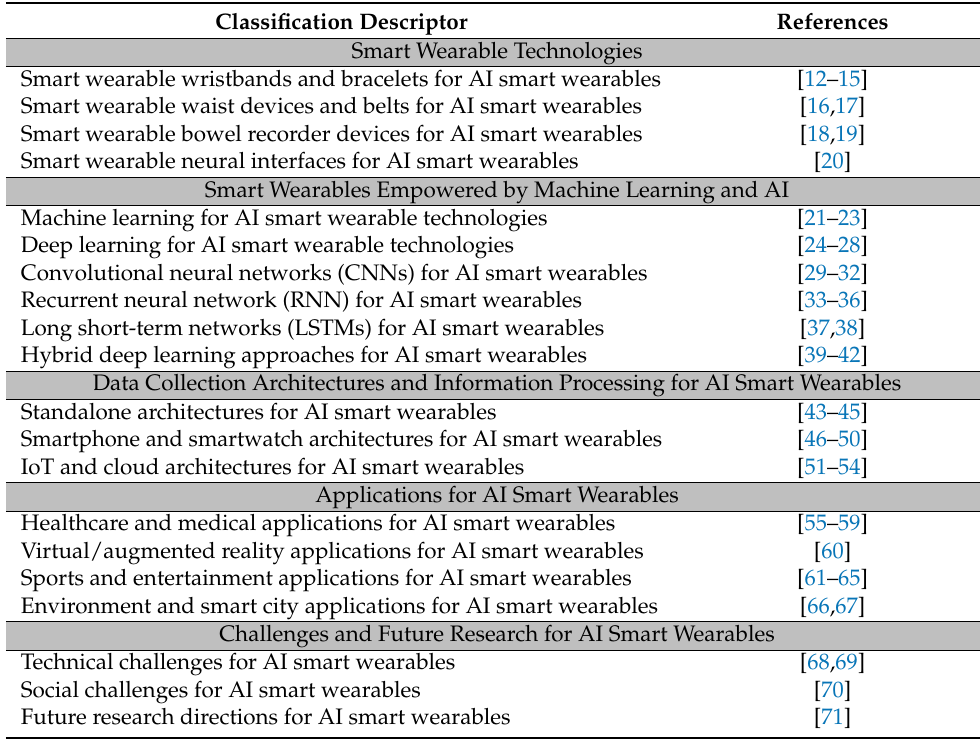
Table 1. Classification descriptors for machine learning and AI technologies for smart